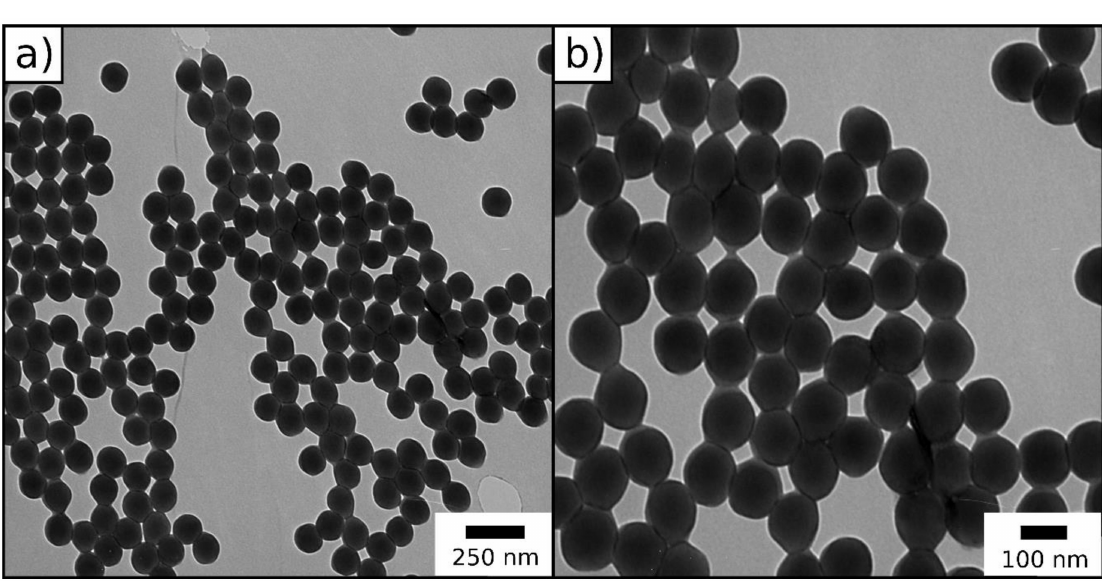
Figure 3. ( a , b ) Transmission electron microscopy (TEM) images of P(MMA- co -ALMA)